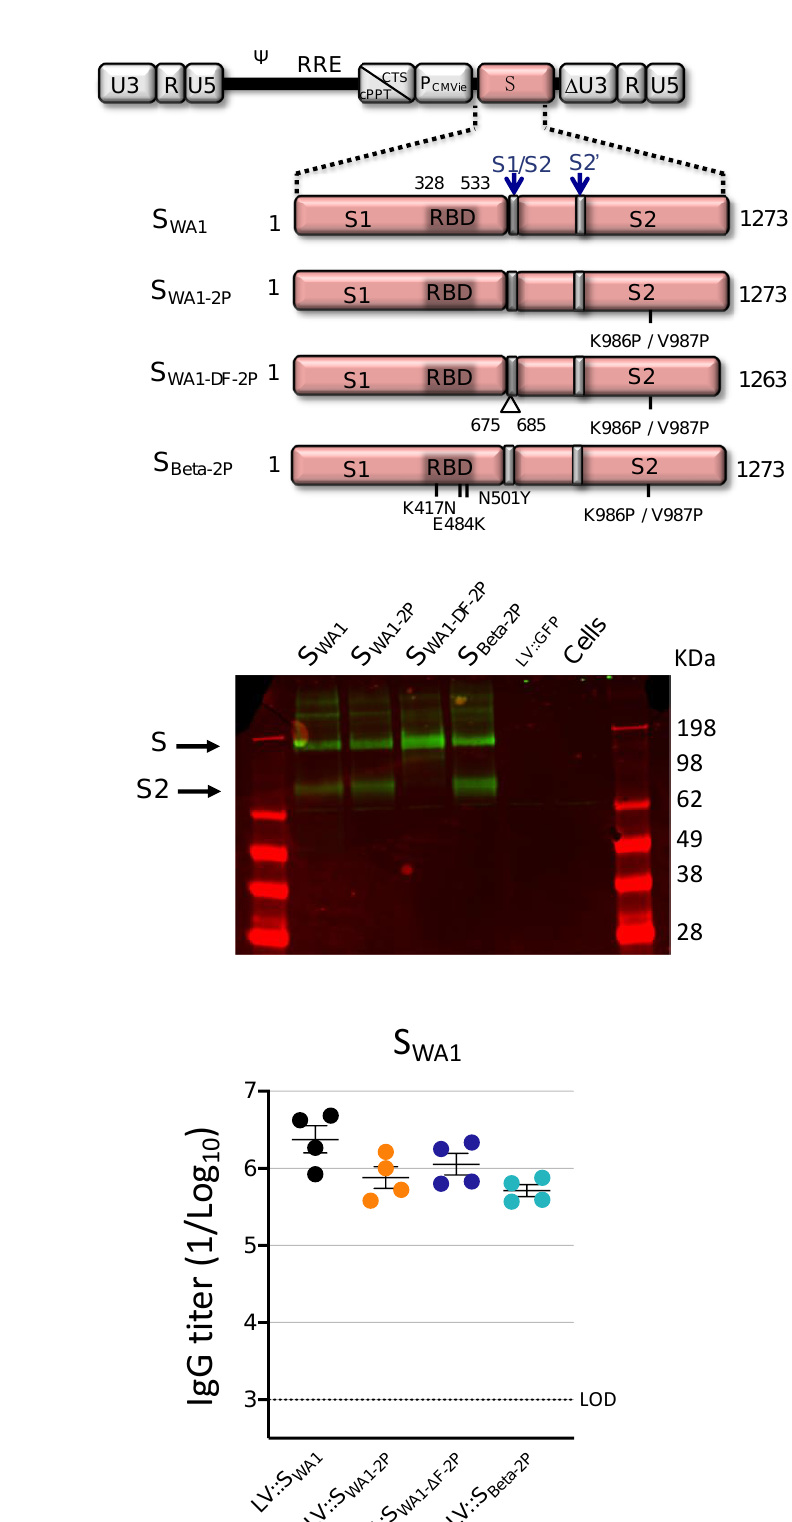
Figure 1. Humoral immunity in hamsters immunized i.m. with various LV::S. ( A ) Schematic repre- sentation of LV-encoding S CoV-2 proteins from either the ancestral WA1 or Beta SARS-CoV-2 strain. Codon-optimized sequences encoding S CoV-2 were cloned into the pFLAP lentiviral vector plasmid, under the control of human P CMVie promoter; RRE, rev response element; cPPT, central polypurine tract. The LV::S WA1 includes the entire sequence of S CoV-2 . RBD , S1/S2, S2′ cleavage sites,